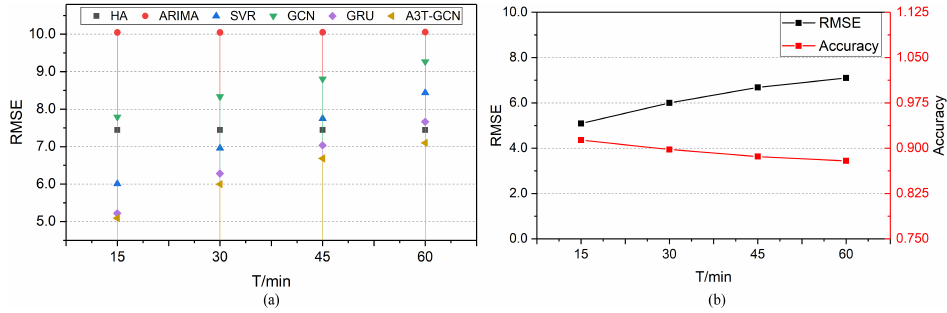
Figure 5. Los-loop: Long-term prediction ability. ( a ) The RMSE of the A3T-GCN and baselines under different prediction horizons. ( b ) The changes in RMSE and accuracy of the A3T-GCN under different prediction horizons.